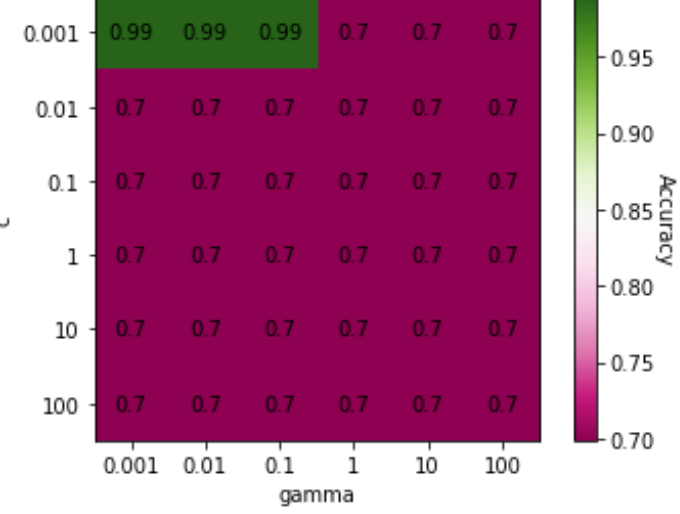
Figure 2. Heatmap of values of SVM parameters C and γ on Dataset 02.